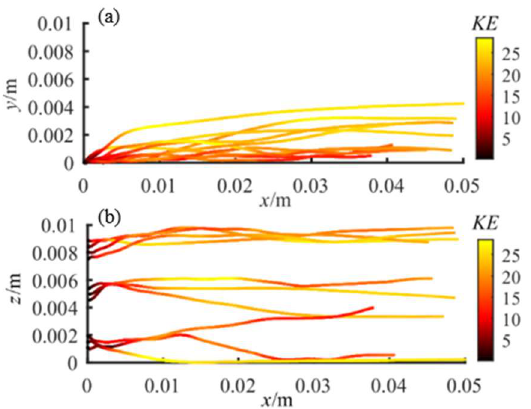
Figure 12. Trajectory and changes in kinetic energy of 10 randomly selected microbubbles: ( a ) projection on an x–y plane and ( b ) projection on an x–z plane.